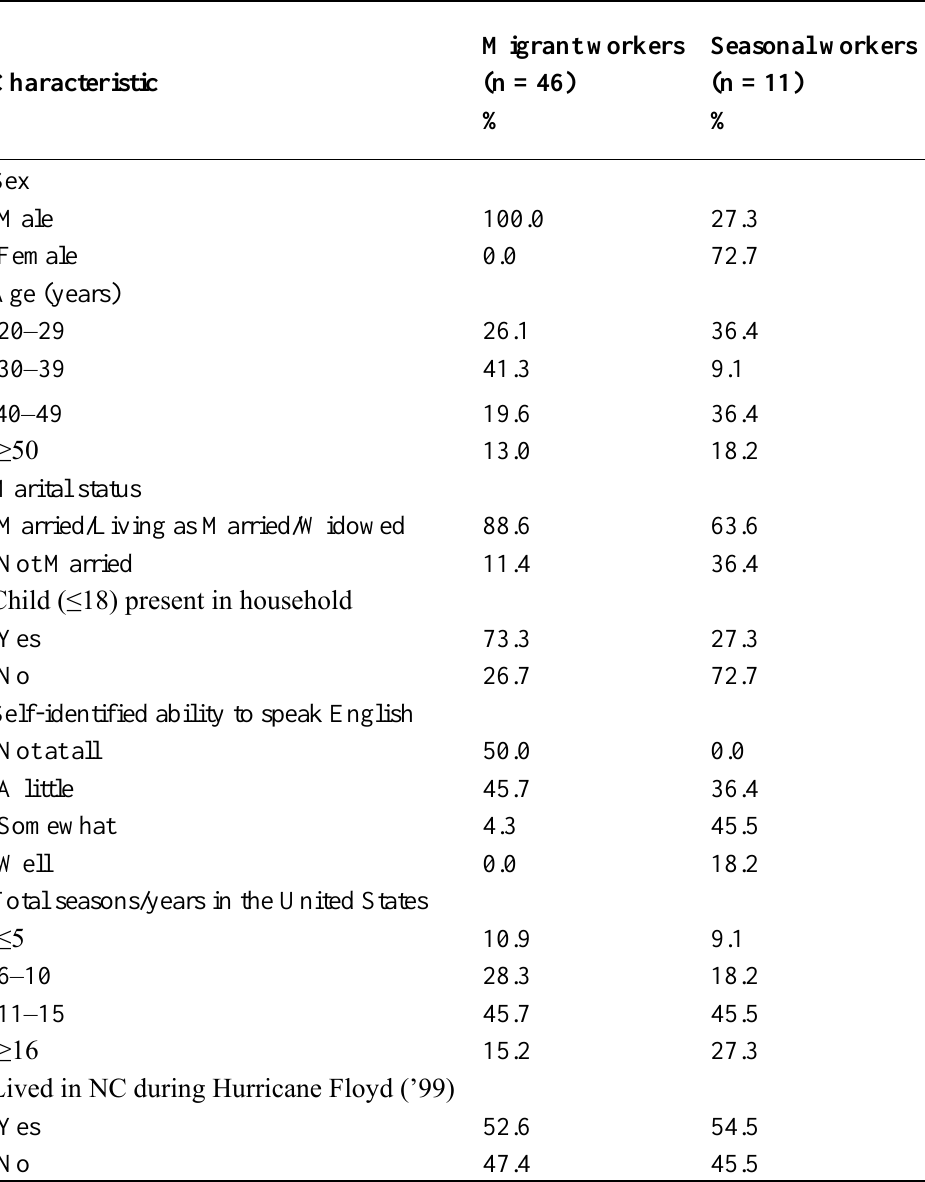
Table 2. Demographic characteristics of survey